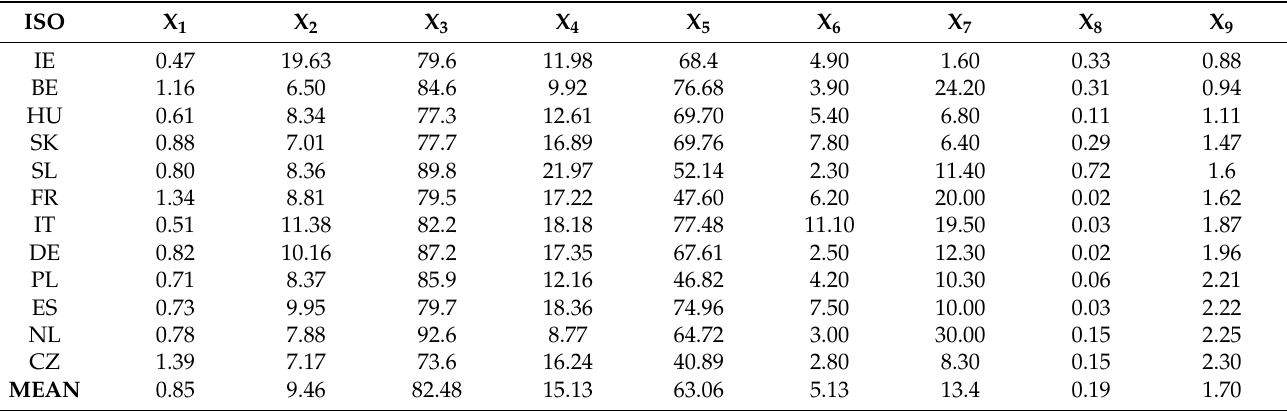
Table 5. “Smart and efficient energy systems”—values of diagnostic variables for countries constitut- ing cluster 2.